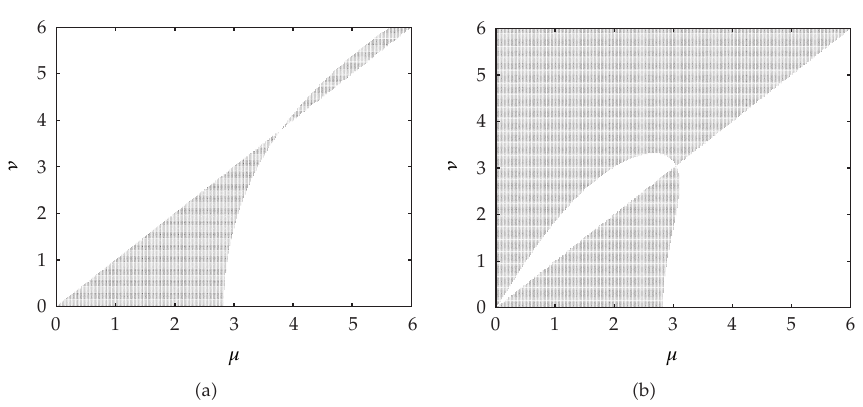
Figure 1: The imaginary stability region of Simos4 (cid:3) a (cid:4) and FRK4a (cid:3) b (cid:4) .